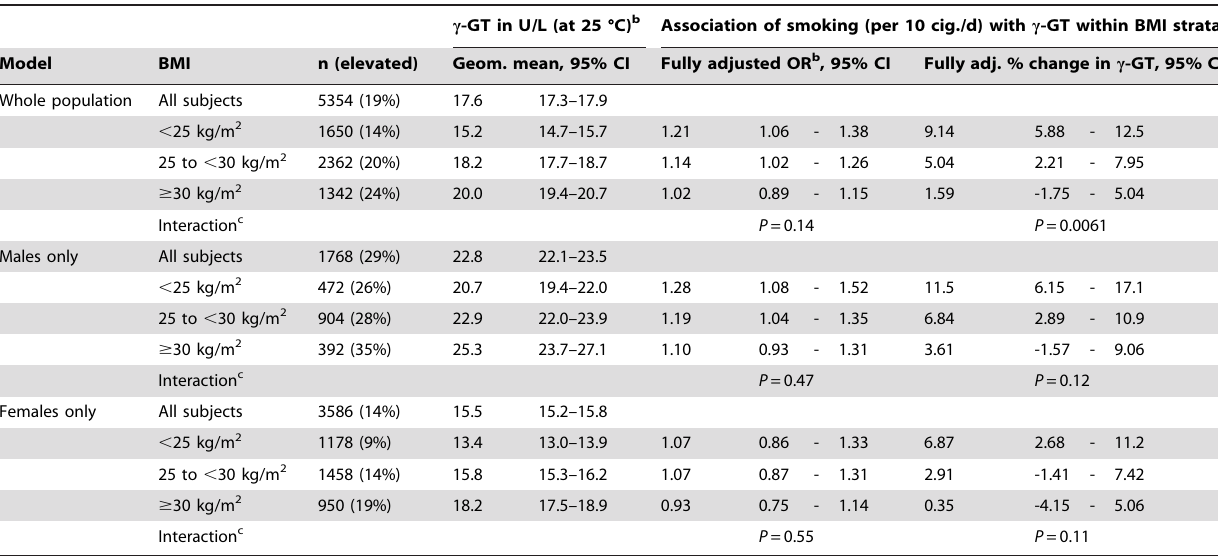
Table 6. Replication analysis in the ESTHER